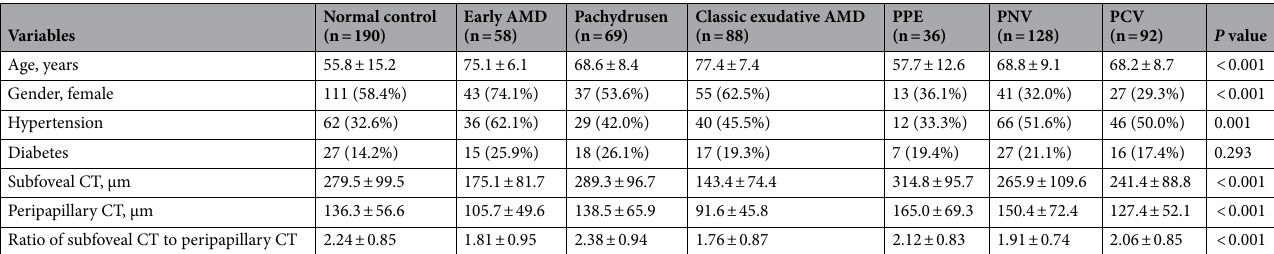
Table 2. Comparison of clinical characteristics and choroidal thickness profiles between different AMD and PSD groups. Data are presented as mean ± standard deviation or number (%). AMD, age-related macular degeneration; Early AMD, early AMD group with soft drusen or reticular pseudodrusen; PPE, pachychoroid pigment epitheliopathy, PNV, pachychoroid neovasculopathy; PCV, polypoidal choroidal vasculopathy; CT, choroidal thickness.